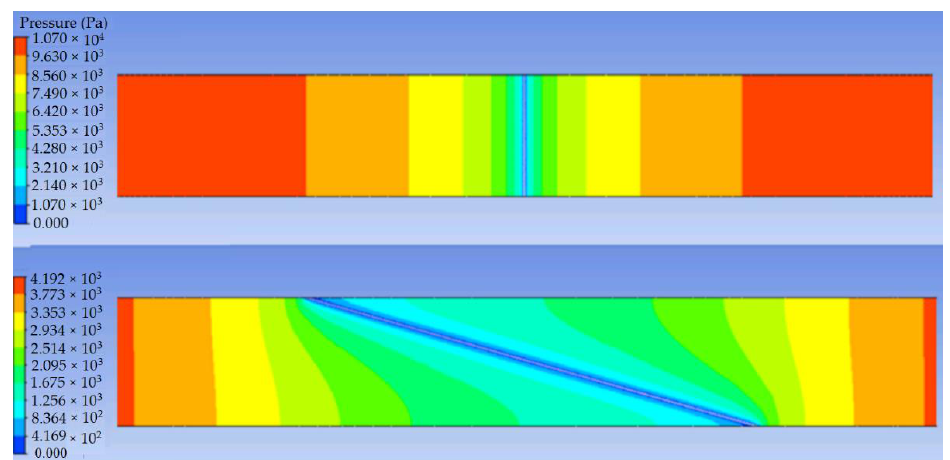
Figure 7. Numerical results of the pressure gradient through the near-wellbore region for vertical angle 90 ◦ and inclination angle 75 ◦ with two dimensionless parameters ( h d = 108.267, k r = 1) and flow rate ( Q = 2 L/min).